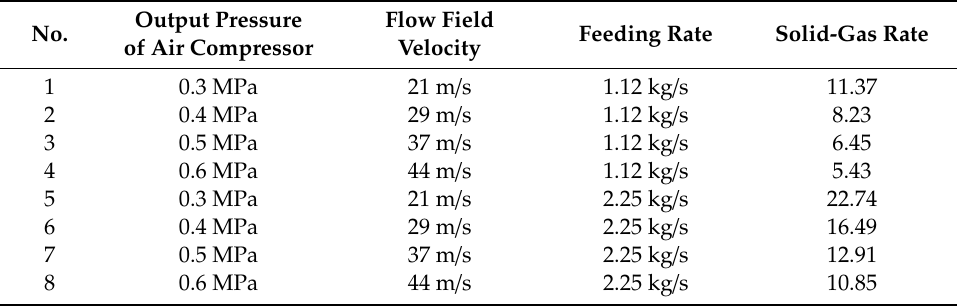
Table 3. The experimental scheme of horizontal pneumatic conveying.